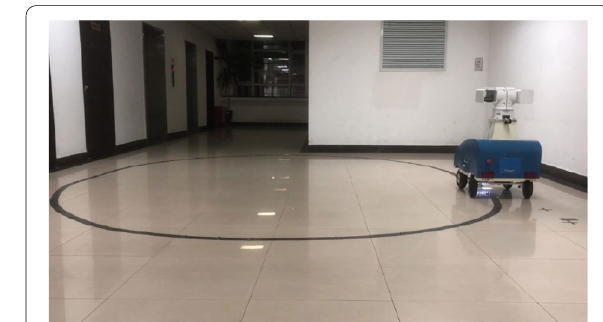
Figure 17 Target trajectory of